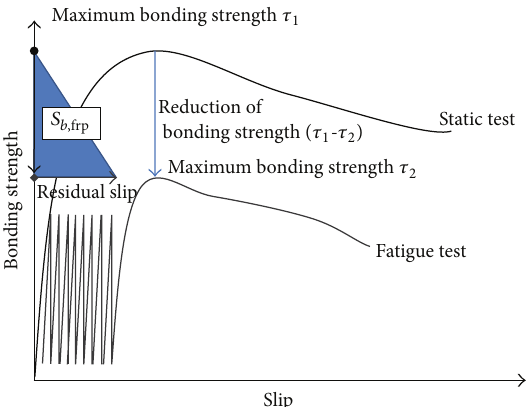
Figure 14: Diagram of the reduction factor of bond stiffness for an FRP reinforcing